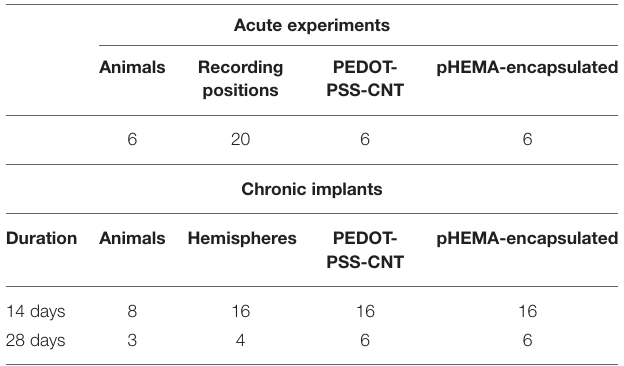
TABLE 1 | Number of animals and probes used during acute experiments and chronic